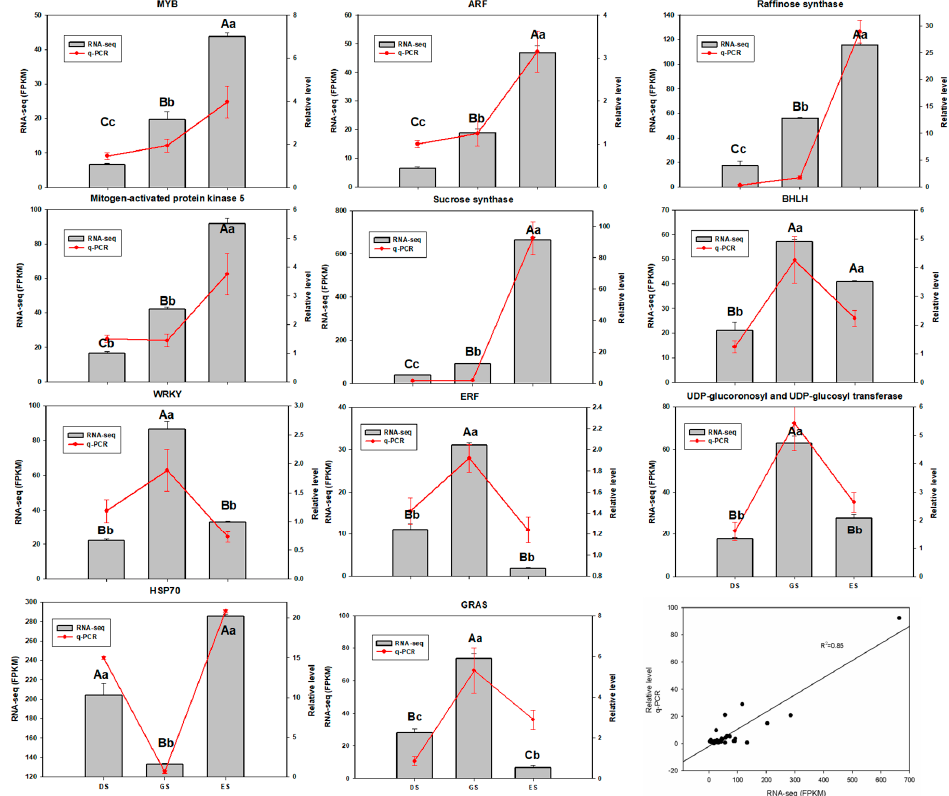
Figure 9. The expression of 11 DEGs and comparison between qRT − PCR and RNA − seq. Note: Different capital letters indicate significant differences among different stages of RNA-seq; different lowercase letters indicate significant differences among different stages of qRT −